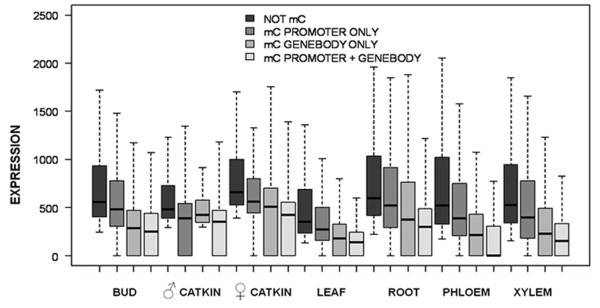
Gene expression in relation to promoter and gene body methylation. Box plot showing average expression of unmethylated genes, genes with methylated promoters, and genes with methylated gene bodies was compared for each tissue type using gene expression data from a Nimblegen microarray. Each box encloses the middle 50% of the distribution (25th percentile - 75th percentile, or interquartile range (IQR)). Lines in boxes mark medians. Lines extending from boxes mark minimum and maximum values that fall within 1.5 times the IQR.